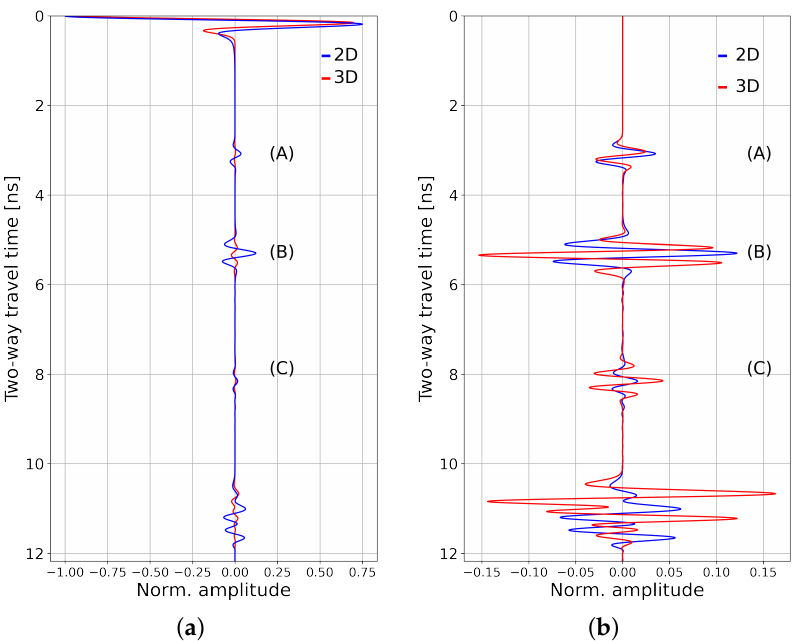
Figure 5. Simulated traces for 2D and 3D geometry with ( a ) direct wave amplitude scaling; ( b ) reflection (A) amplitude scaling for 2D/3D comparisons and zeroing the direct wave ampli- tudes for visualisation